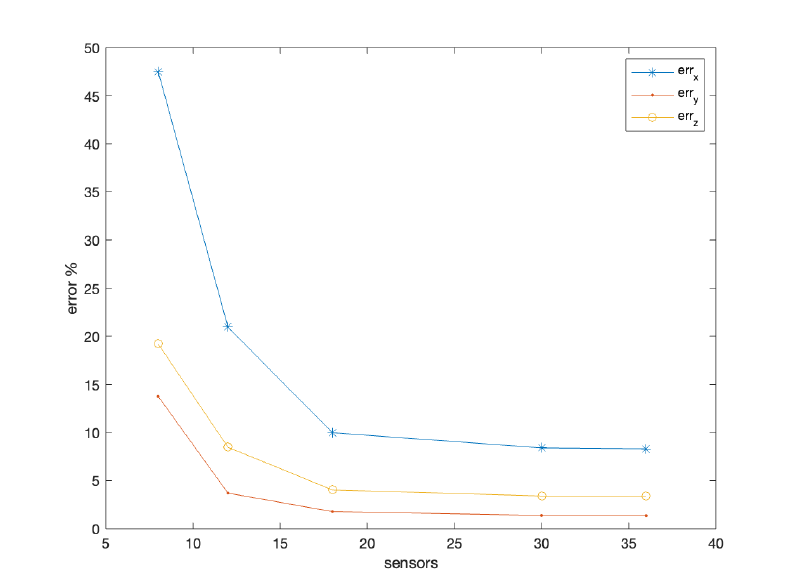
(cid:13) (cid:13) (cid:13) (cid:16)(cid:13) (cid:17) Ref (cid:13) (cid:13) (cid:13) (cid:13) Corr − U Ref / in percentage, with x , y , z x , y , z (cid:13) (cid:13) (cid:13) U (cid:13) U x , y , z 2 2